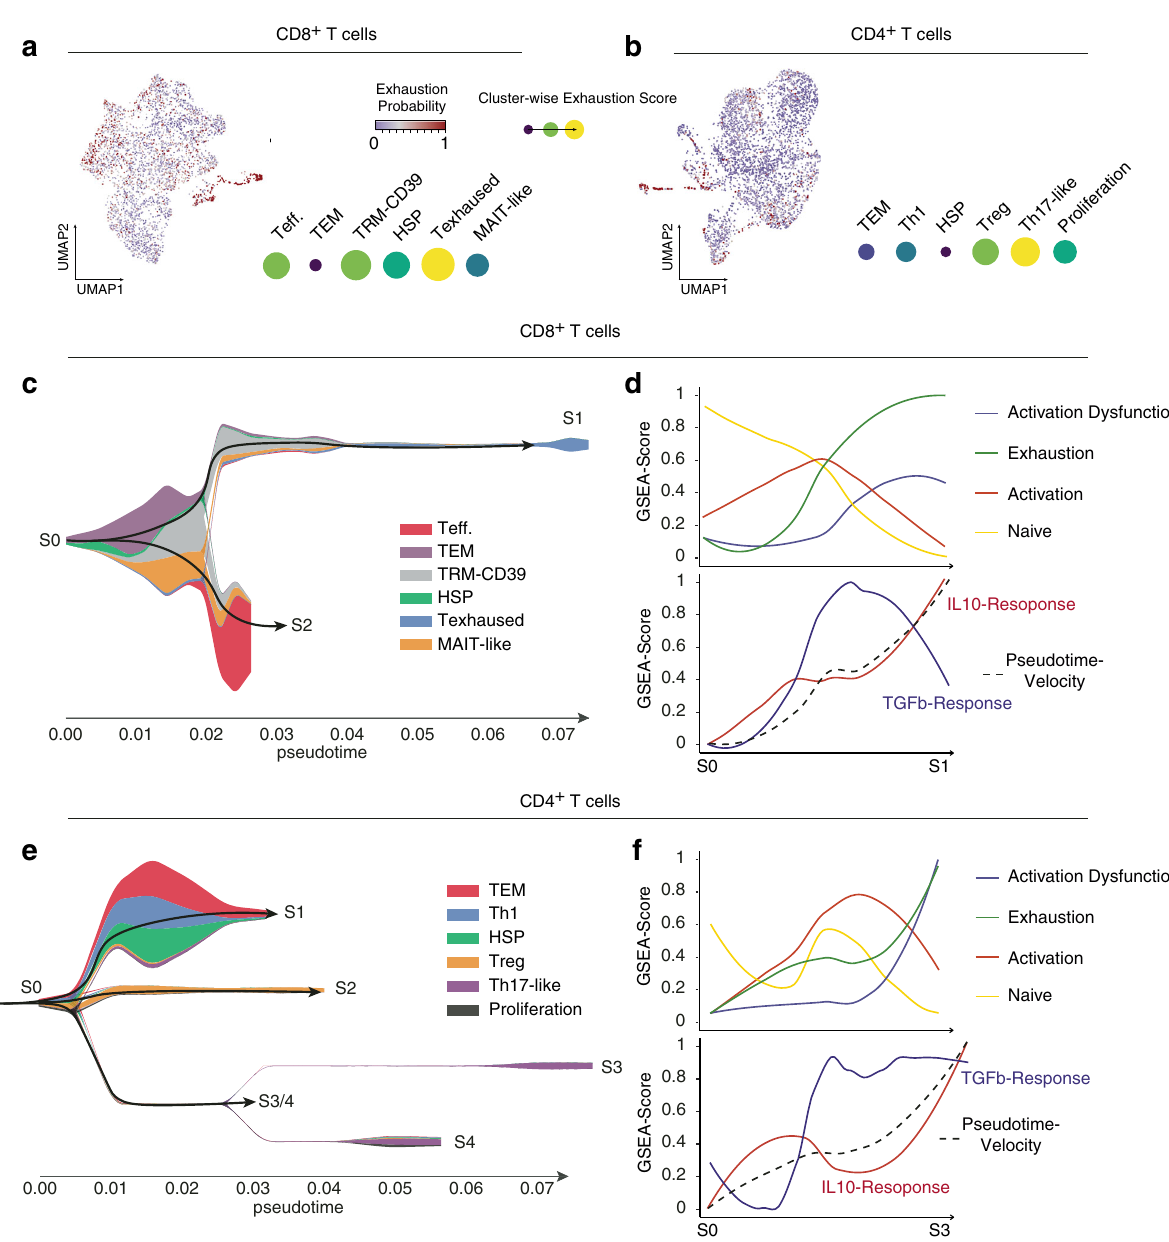
Fig. 2 Pseudotemporal analysis of T cell differentiation. a , b UMAP dimensional reduction for CD8 + (left) and CD4 + T cells. Colors indicate the enrichment of T cell exhaustion. Cluster-wise enrichment analysis is illustrated by points, which are sized and colored according to their enrichment score for T cell exhaustion. c For CD8 + T cells: The two identi fi ed terminal states (indicated by colors, names S1-S2) are presented using a two-dimensional subway plot. Terminally exhausted T cells fall under state 1 (S1). d For CD8 + T cells: Line plots with pseudotime (from S0 to S1 state) at the x-axis and enrichment scores of different T cell states on the y-axis (upper plot). At the bottom, the RNA-velocity from S0 to S1 state is illustrated (dashed line) with increasing velocity-pseudotime on the y-axis. Additionally, IL-10 and TGFb response is shown (red and blue lines). e Similar visualization ( c ) from CD4 + T cells. These cells reveal a more complex architecture mainly spanning the three major cell states from regulatory T cells (branch S2), TEM/Stress (Branch S1), and Th17 (Branch S3/S4). f Similar representation ( d ) for CD4 + T cells with enrichment for T cell states (upper plot) and velocity and IL-10/ TGFb response (bottom